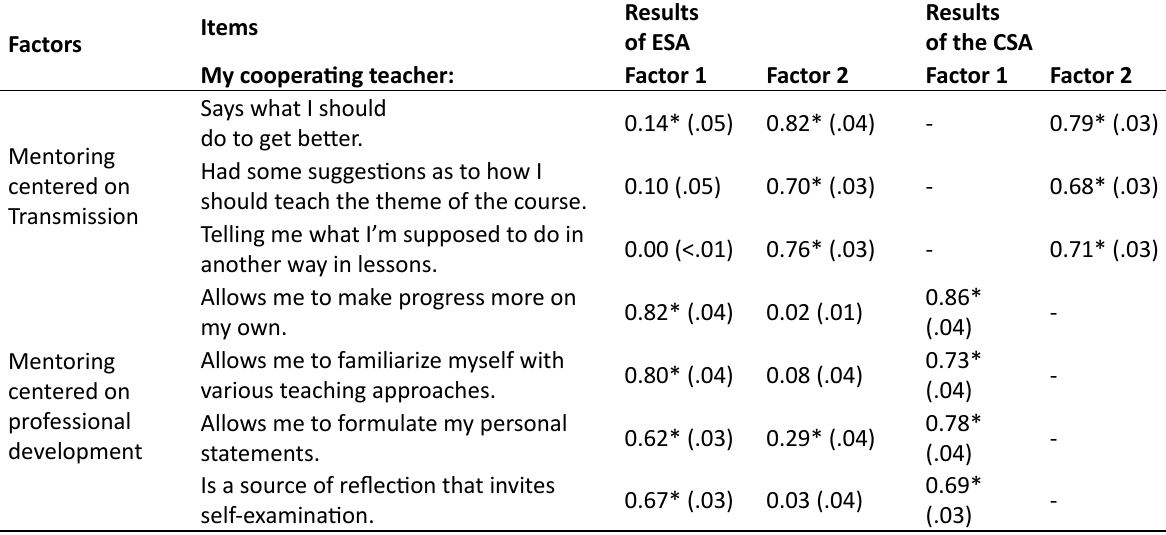
Table 1. Factor saturation for exploratory and confirmatory scaling analysis Factors